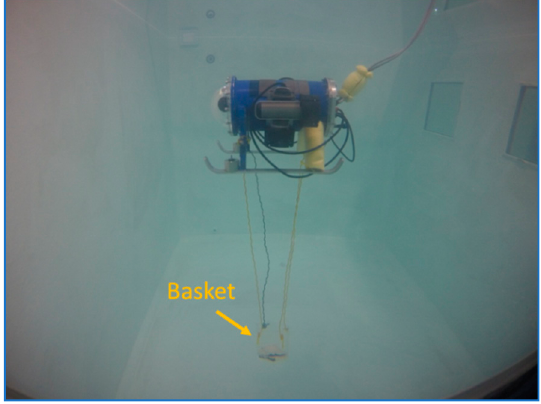
Figure 7. Basket attached to the mini-ROV used to hold the weight.